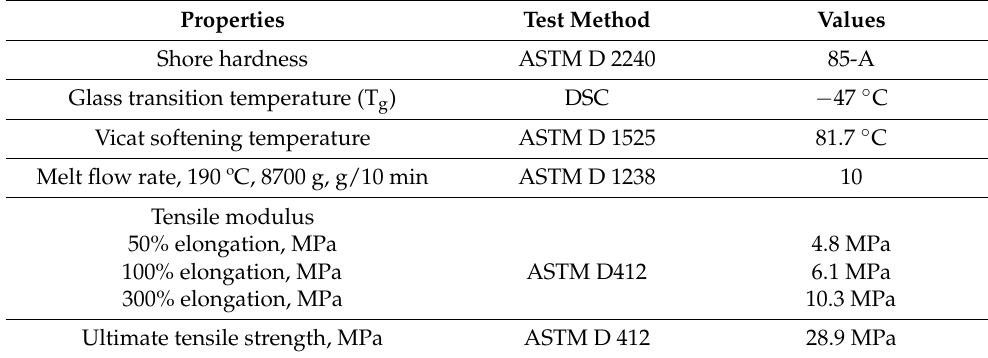
Table 1. Specific properties of Pellethane 2363